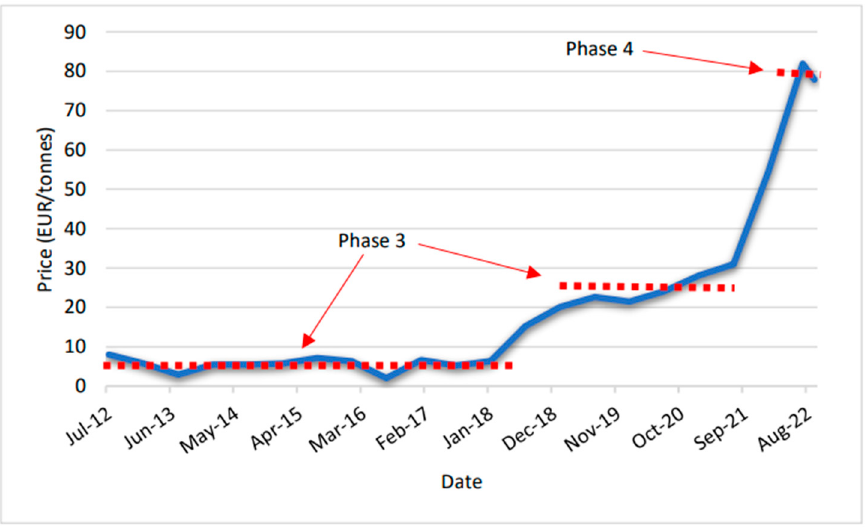
Figure 4. Prices of EU carbon permits from July 2012 (adapted from EMBER [47] and Trading Economics [48]). The dotted lines represent different periods of stable prices.